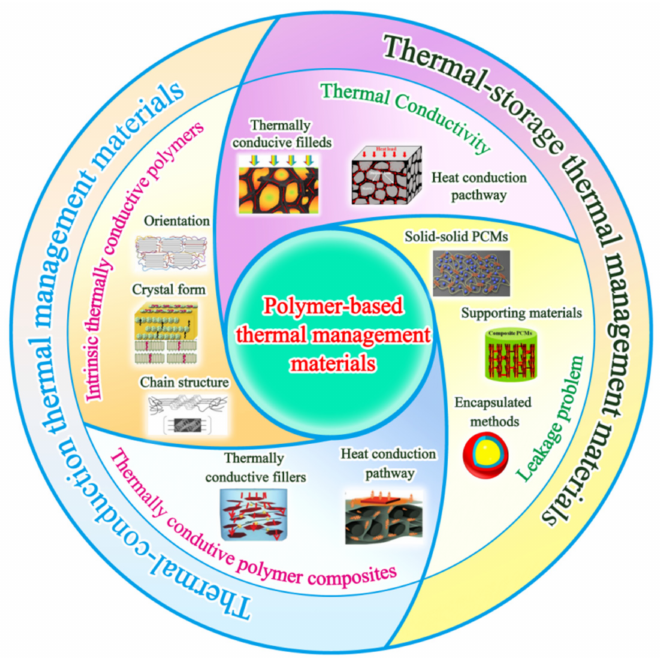
Figure 1. Schemes of two important types of polymer-based thermal management material reported in this